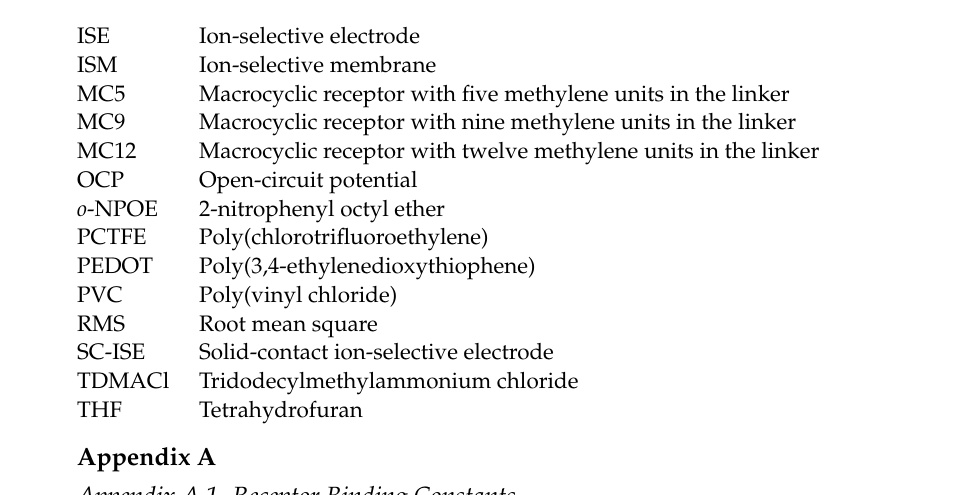
Table A1. Binding constants that have been published previously for the receptors and the mono- carboxylates that were included in this study [28,30]. The binding constants were determined